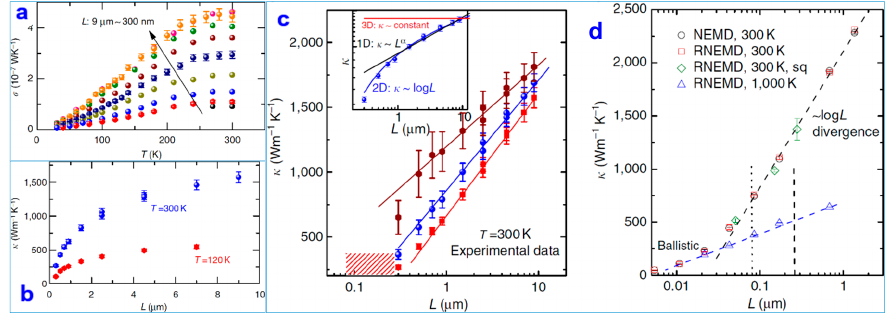
Figure 10. ( a ) The variation in the thermal conductance ( σ ) of a graphene nanoribbon with temperature (T) over a length of 9 μ m to 300 nm. ( b ) Image of the TC ( κ ) with length (L) at (T) over a length of 9 µ m to 300 nm. ( b ) Image of the TC ( κ ) with length (L) at temperatures of 120 K and 300 K. R total is the thermal contact thermal resistance. Experimental ( c ) and various simulation methods ( d ) results on length-dependent thermal conductivity [76]. Copyright 2014, Springer